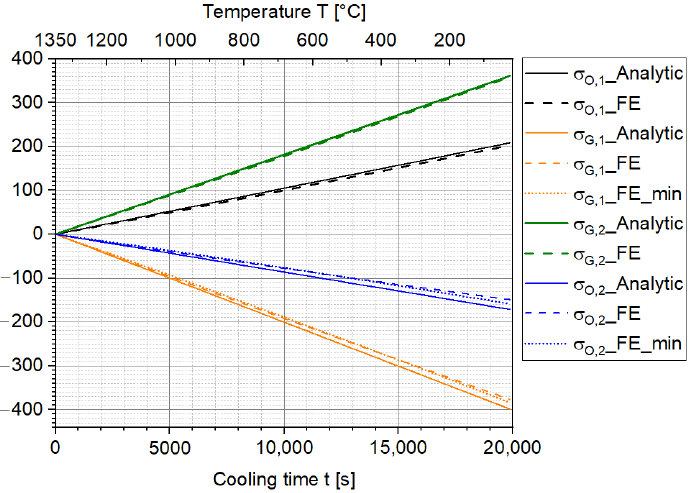
Figure 9. Comparison of the stress distributions in the two-layer MCLs between the analytic solution and FE simulation for the ideal scenario.